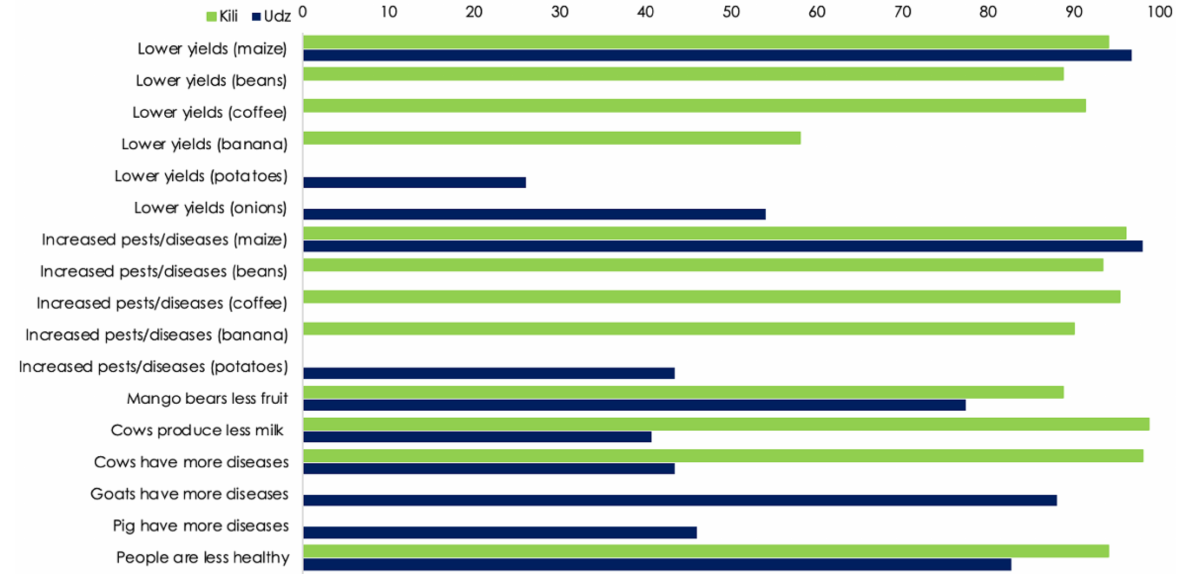
Figure 3. Observed impacts in the biological domain regarding percent of respondents in each mountain ( n = 150 on Mount Kilimanjaro, n = 150 on the Udzungwa Mountains). Coffee and green bananas are not cultivated in our study area of Udzungwa Mountains. Although Irish potatoes, onions, pigs, and goats are grown by some farmers on Mount Kilimanjaro, we excluded these in the questionnaire on Mount Kilimanjaro as they are not